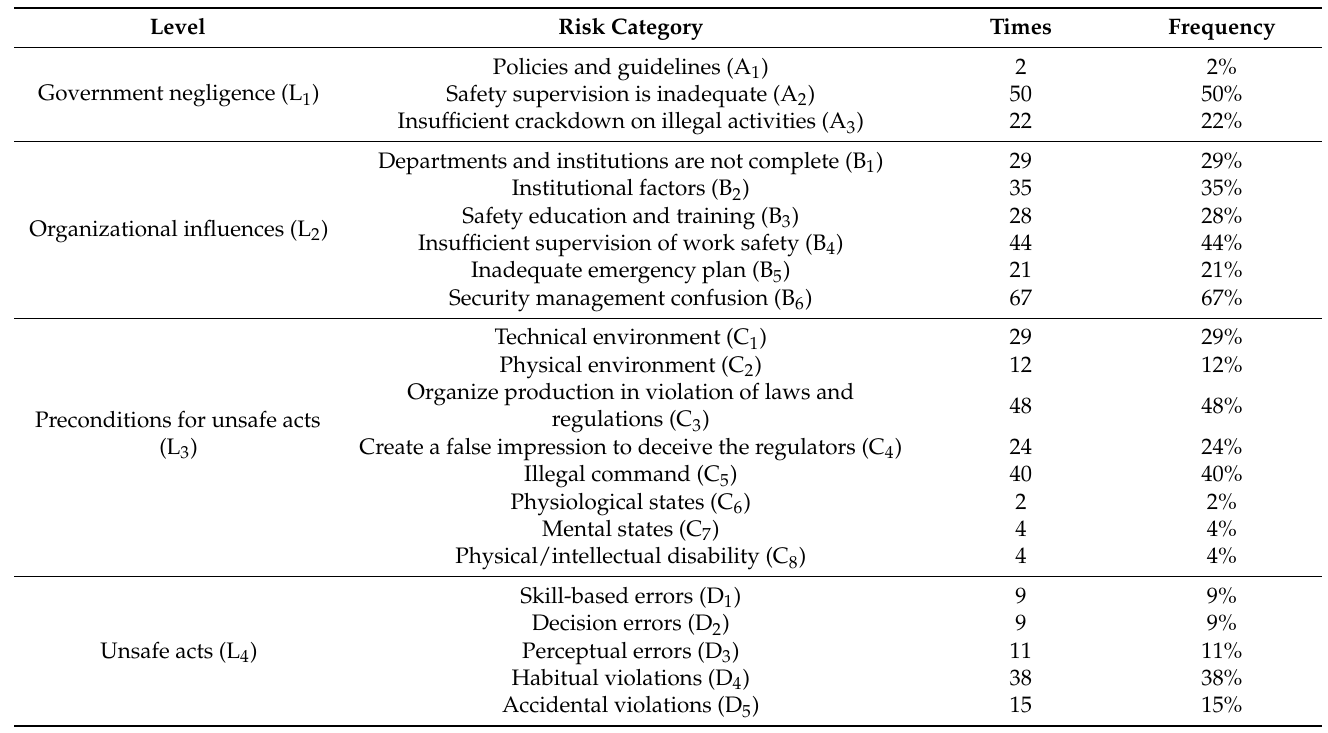
Table 4. Risk factor frequency statistics